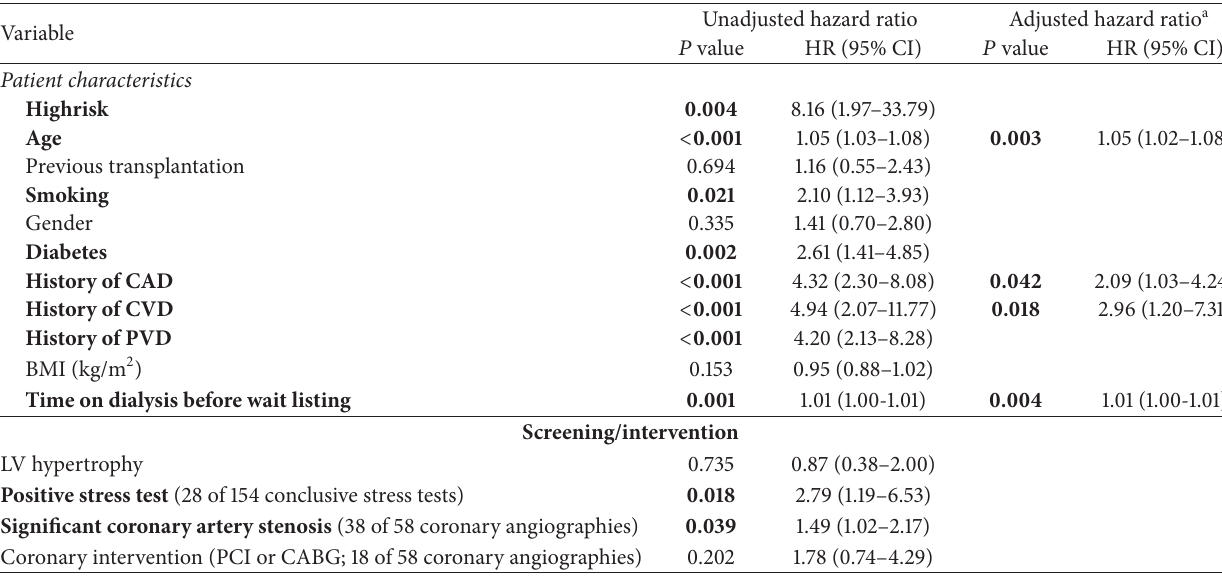
Table 4: Unadjusted and adjusted HR for predictors of MACE after wait